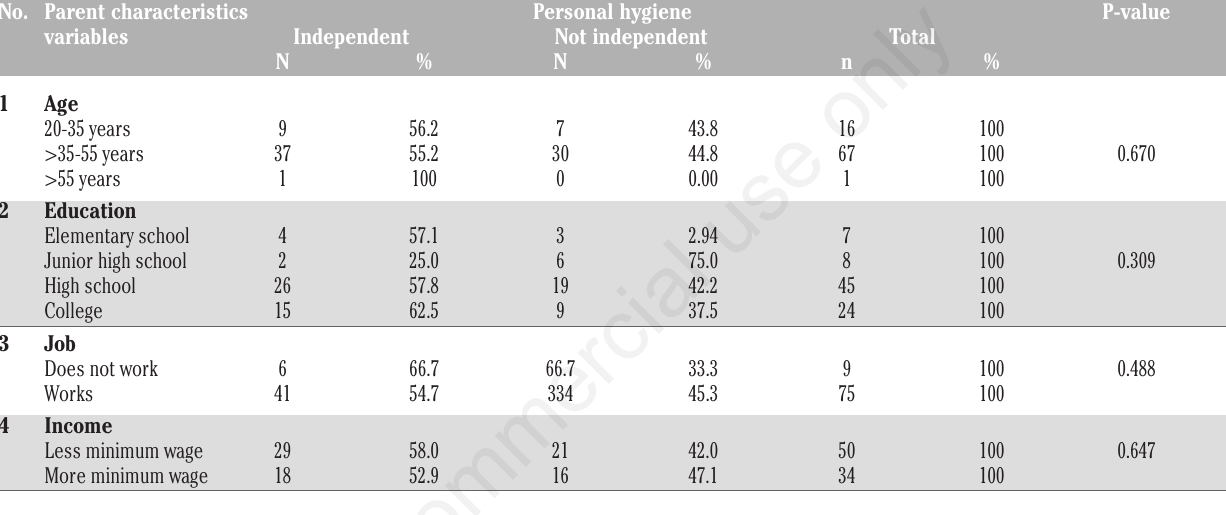
Table 1. Distribution of the relationship characteristics of parents of children with special needs with the ability to maintain personal hygiene in Bogor (n=84).